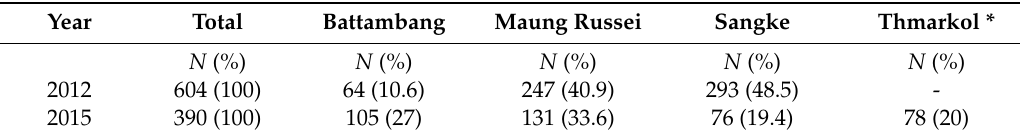
Table 1. Data for the Operational Districts by